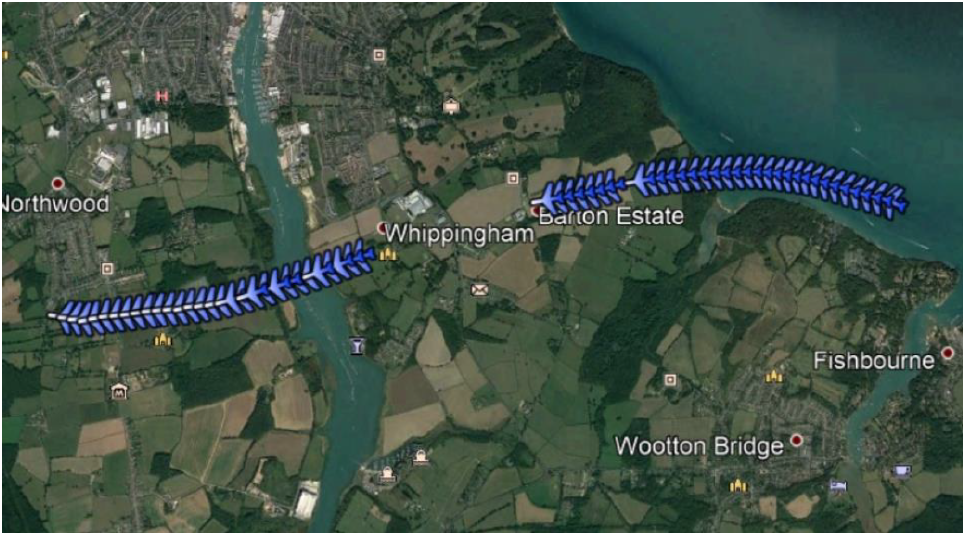
Figure 18. A screenshot from the first version of the